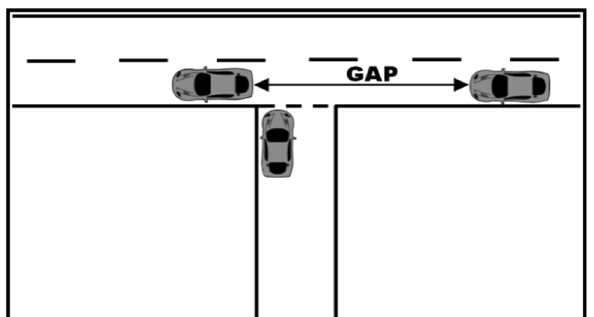
Fig. 1 Schematic diagram of gap